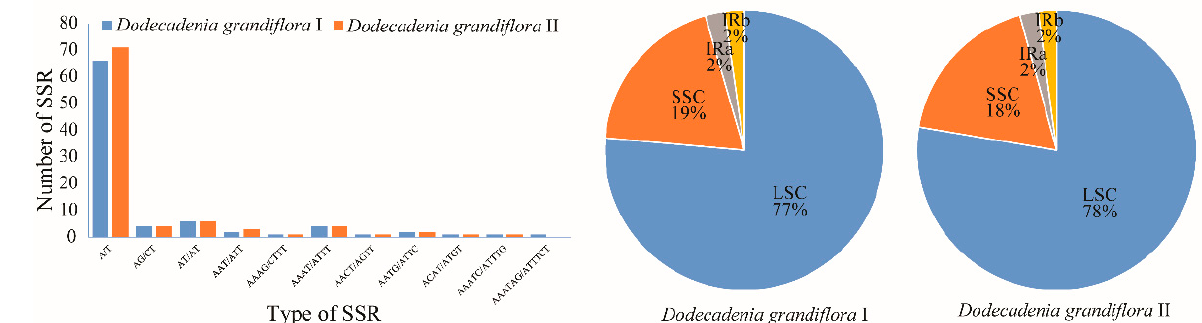
Figure 5. Number and distribution of SSRs in two plastomes of D. grandiflora.